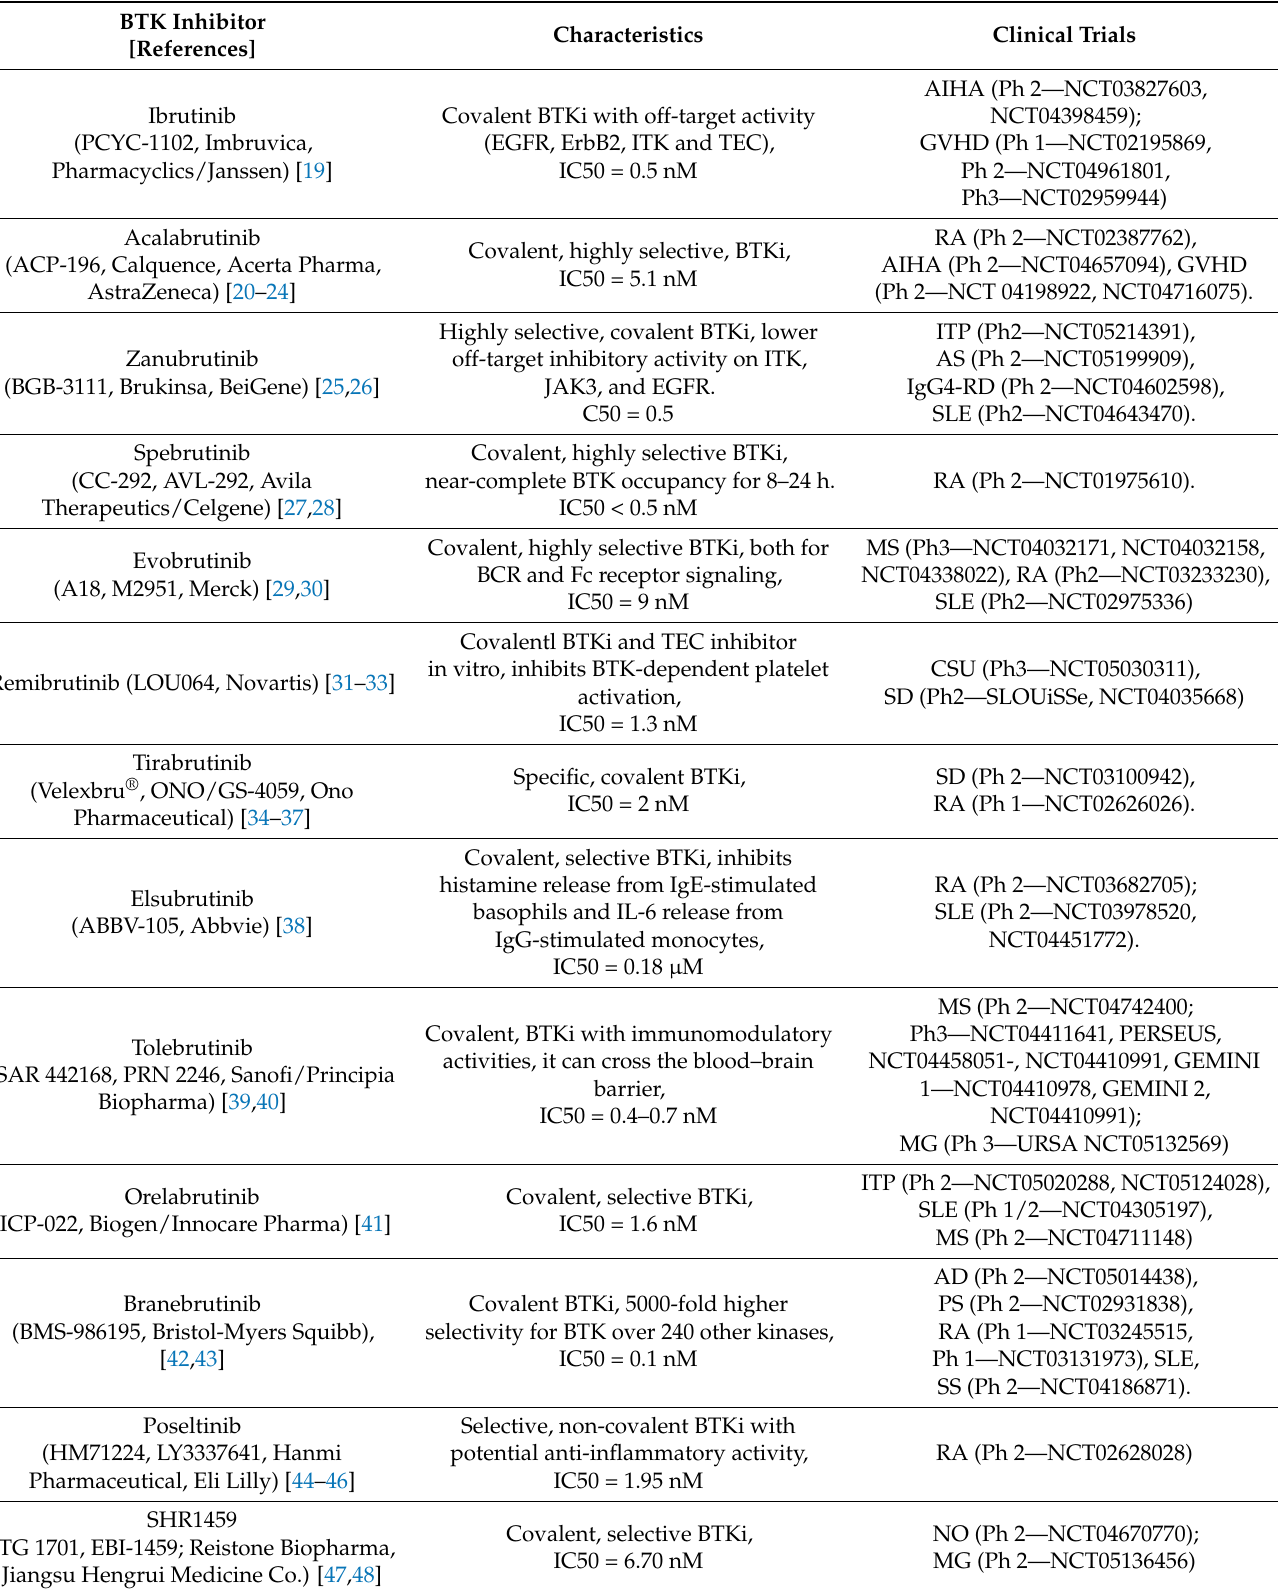
Table 1. Irreversible BTK inhibitors studied in immune